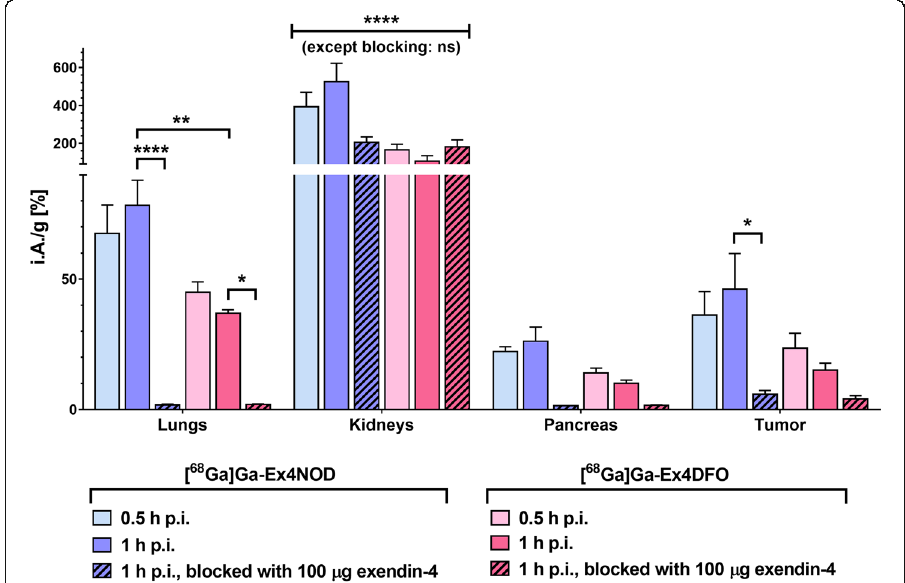
Fig. 2 Selected organs from a timecourse biodistribution with [ 68 Ga]Ga-Ex4NOD and [ 68 Ga]Ga-Ex4DFO, performed in GLP-1R positive tumor-bearing CD 1 nu/nu mice ( n = 4 per group). For both tracers, blocking at 1 h p.i. was achieved in all GLP-1R-expressing